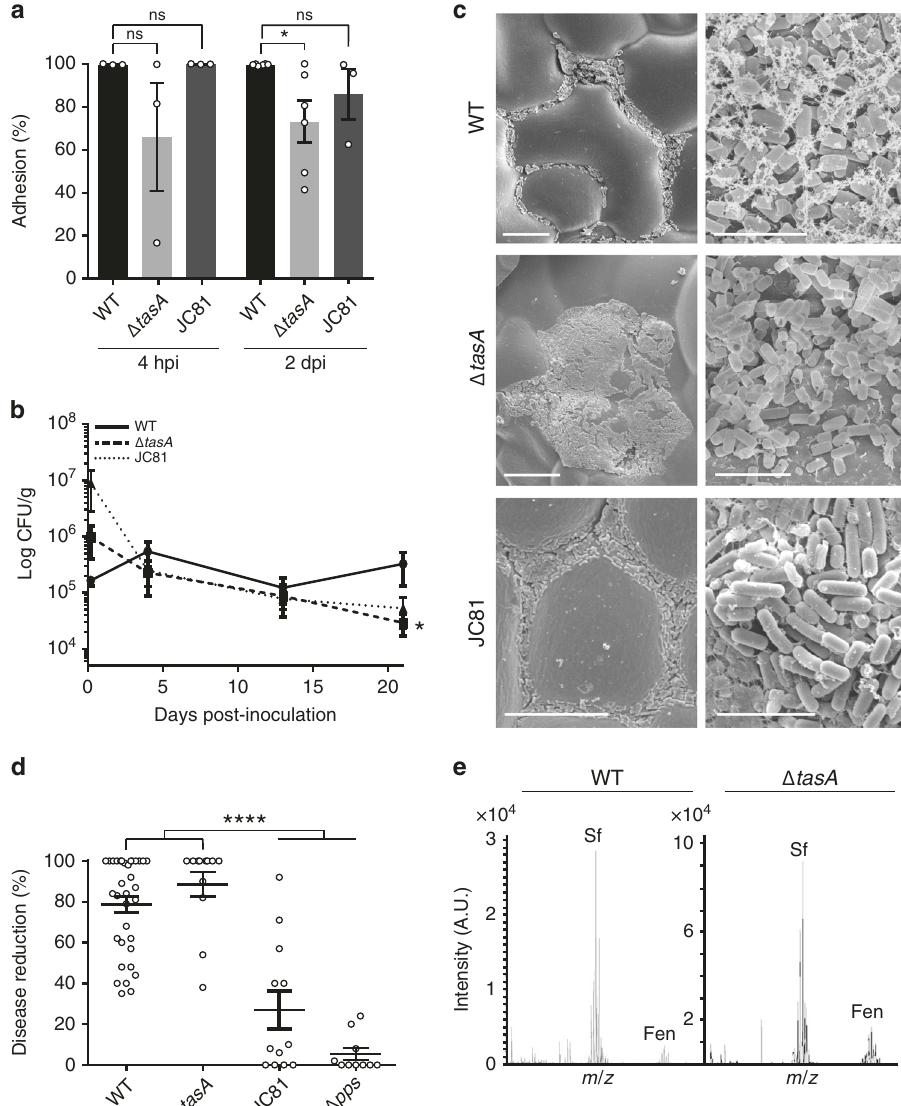
Fig. 1 TasA is essential for the fi tness of Bacillus on the melon phylloplane. a Adhesion of the WT, Δ tasA and JC81 (TasA Lys68Ala, Asp69Ala) strains to melon leaves at 4 h (hpi) and 2 days post-inoculation (dpi). Statistically signi fi cant differences between WT and Δ tasA were found at 2 dpi. At 4 hpi, N = 3 for all the strains. At 2 dpi N = 6 for the WT strain, N = 6 for the Δ tasA strain and N = 3 for the JC81 strain. N refers to the number independent experiments. In each experiment, 10 leaves were analyzed. Average values are shown. Error bars represent the SEM. Statistical signi fi cance was assessed via two-tailed independent t -tests at each time-point (* p value = 0.0262). b The persistence of the Δ tasA cells at 21 days was signi fi cantly reduced compared with that of the WT cells. The persistence of JC81 cells on melon leaves was reduced compared to that of the WT cells. The fi rst point is taken at 4 hpi. Average values of fi ve biological replicates are shown with error bars representing the SEM. Statistical signi fi cance was assessed by two-tailed independent t -test at each time-point (* p value = 0.0329). c Representative scanning electron microscopy micrographs of inoculated plants taken 20 days post-inoculation show the WT cells (top) distributed in small groups covered by extracellular material and the Δ tasA cells (bottom) in randomly distributed plasters of cells with no visible extracellular matrix. JC81 (TasA Lys68Ala, Asp69Ala) strain shows an intermediate colonization pattern between those of the WT and Δ tasA null mutant strains. Scale bars = 25 µ m (left panels) and 5 µ m (right panels). Experiments have been repeated at least three times with similar results. d The WT and Δ tasA strains showed comparable biocontrol activity against the fungal phytopathogen Podosphaera xanthii . However, JC81 (TasA Lys68Ala, Asp69Ala) failed to control the disease. Biocontrol activity was measured after 15 days post-inoculation of the pathogen. For the WT strain, N = 22. For the Δ tasA strain and JC81 strain, N = 12. For the Δ pps strain, N = 9. N refers to number of plants analyzed over three independent assays. Three leaves per plant were infected and inoculated. Average values are shown with error bars indicating the SEM. The Δ pps is a mutant strain in fengycin production and it is used as a negative control. Statistical signi fi cance was assessed by two-tailed independent Mann – Whitney tests between each strain and the Δ pps mutant (**** p < 0.0001). e MALDI-TOF/TOF MS analysis revealed higher fengycin levels on melon leaves treated with Δ tasA (right) cells compared with that on leaves treated with WT cells (left) after 20 days post-inoculation. Source data are provided as a Source Data fi